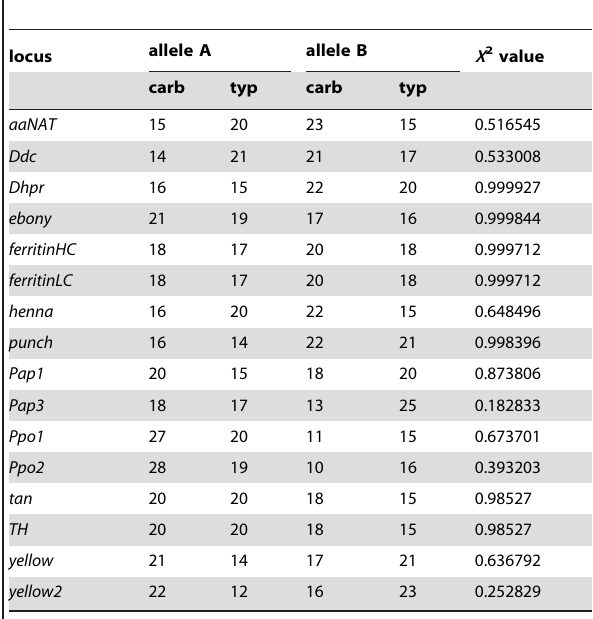
Table 2. Test of association between genetic variation in 16 melanisation gene candidates and offspring